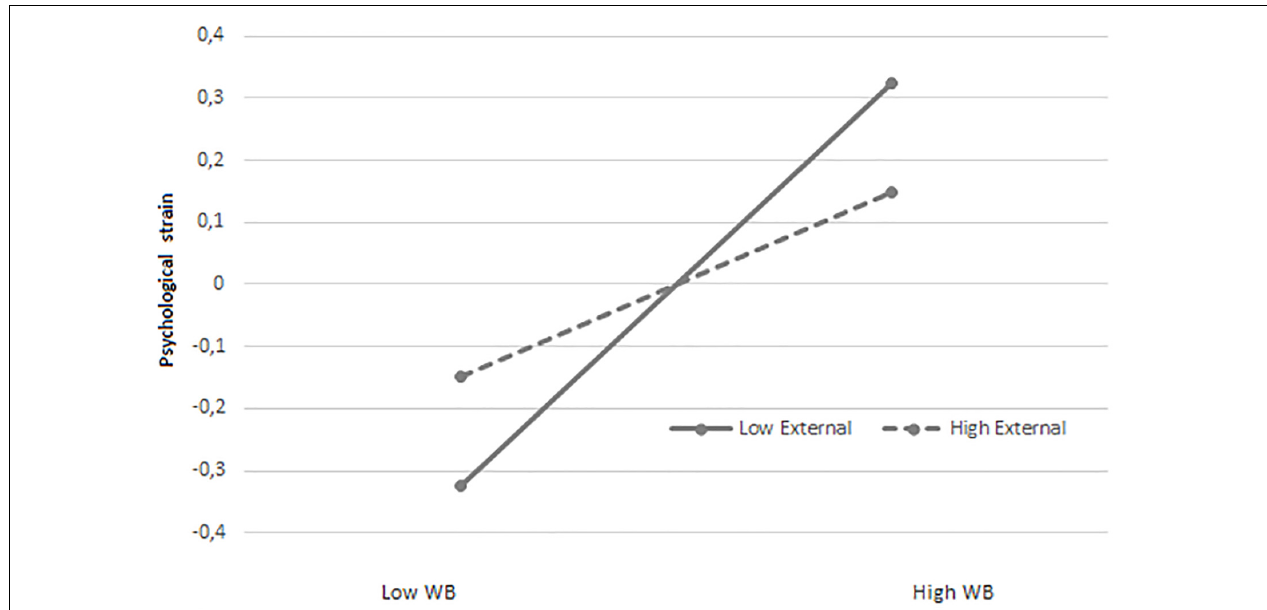
FIGURE 4 | The interaction effect of workplace bullying and external locus of control on psychological strain. Low = 1 SD below the mean. High = 1 SD above the mean. WB = workplace bullying. External = external locus of